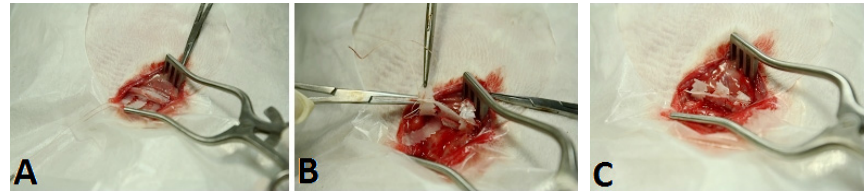
Figure 3. Surgical procedure of the PCL cable ‐ tie fixator. ( A ) Passed the belt beneath the rib; ( B ) Locked the belt; ( C ) Final fixation.